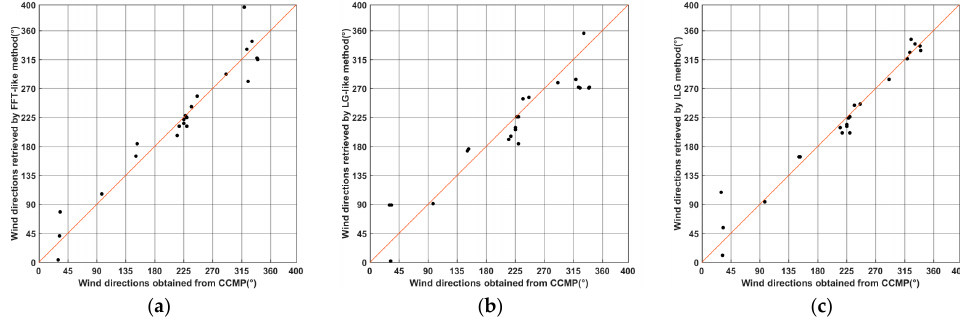
Figure 7. Comparison of wind directions between each retrieval method and CCMP: ( a ) FFT-like method, ( b ) LG-like method and ( c ) ILG method.